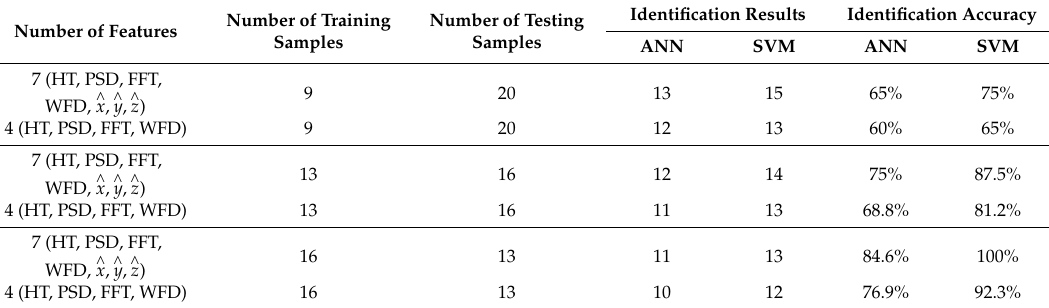
Table 4. Damage identification results based on multi-feature